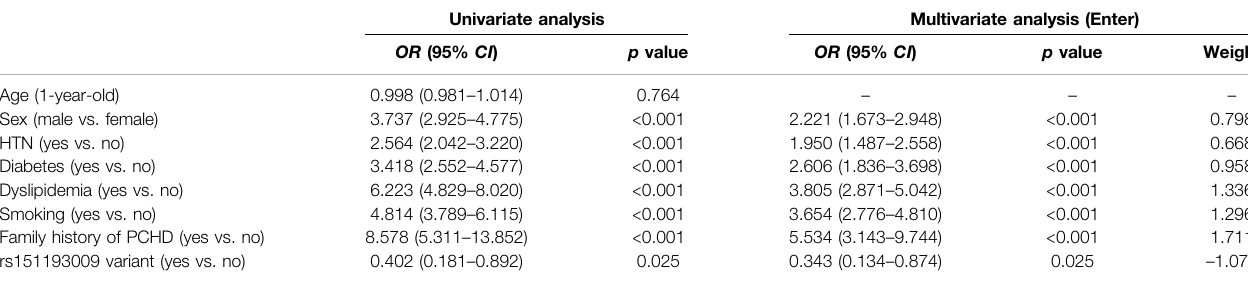
TABLE 5 | Logistic regression analysis of factors for PMI in Cohort 1